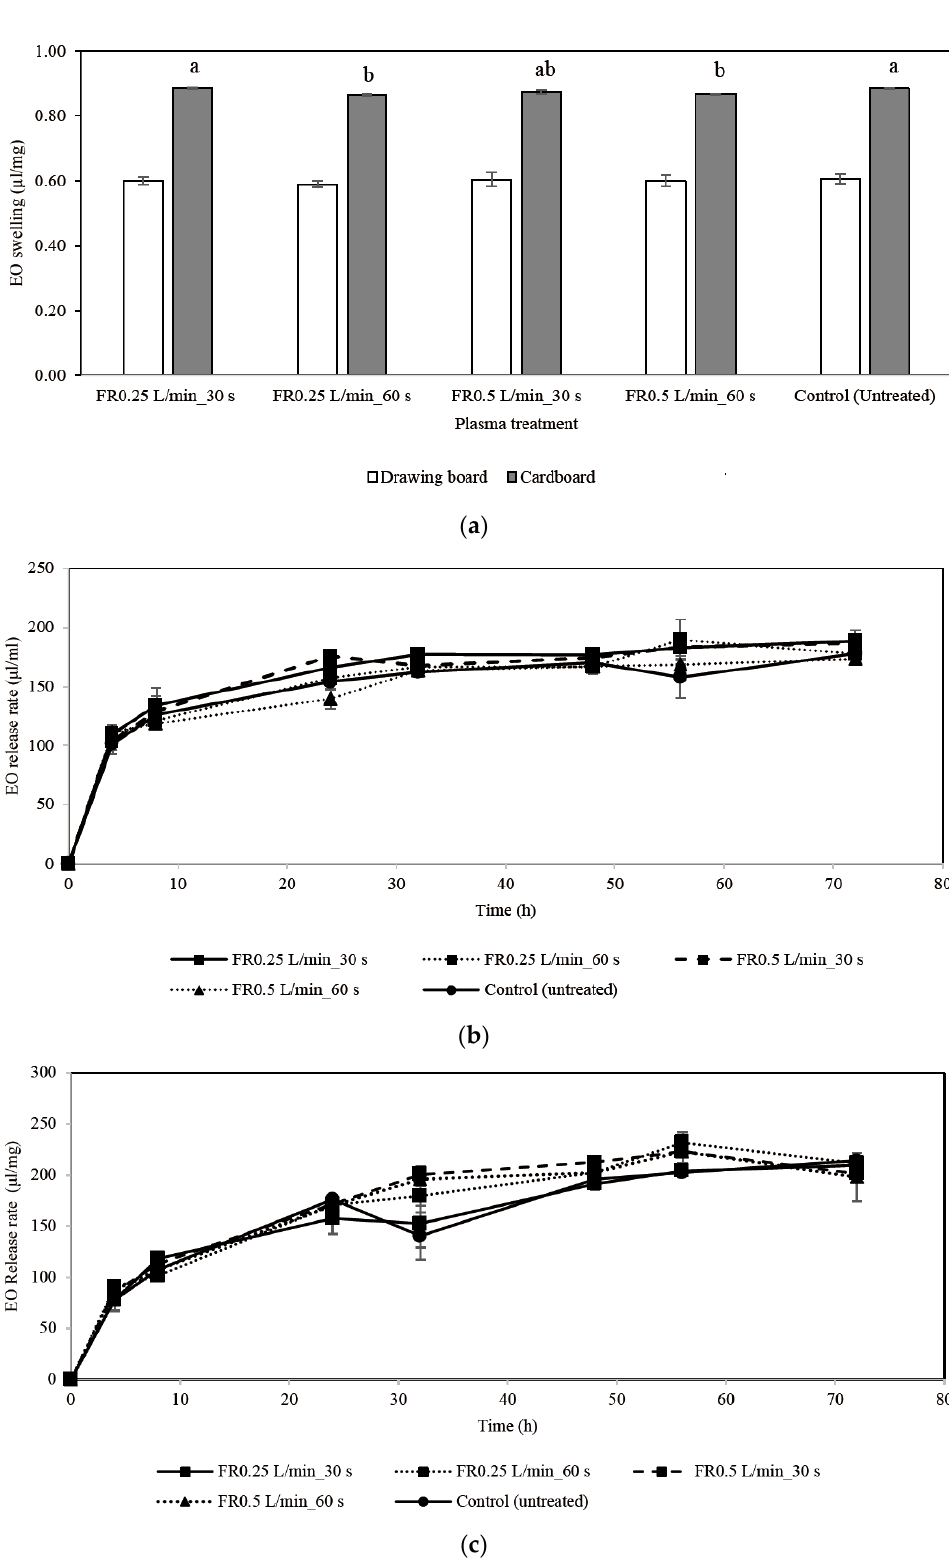
Figure 3. Absorption capacity of A. krervanh EO by cardboard, and drawing board ( a ), and release rate of EO by cardboard ( b ) and drawing board ( c ) after plasma treatment. Data shown are the means ± standard deviation. Different lowercase letters represent significant difference ( p <